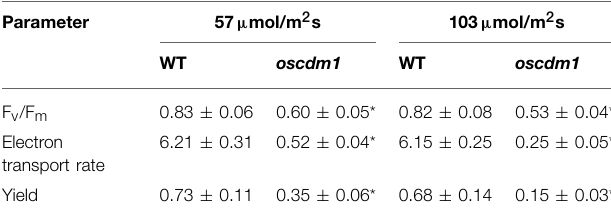
TABLE 2 | Comparison of fluorescence parameters between wild-type (WT) and oscdm1 rice leaves ( n = 15 ), the asterisks shows significantly different between the oscdm1 mutant and wild type at P ≤ 0